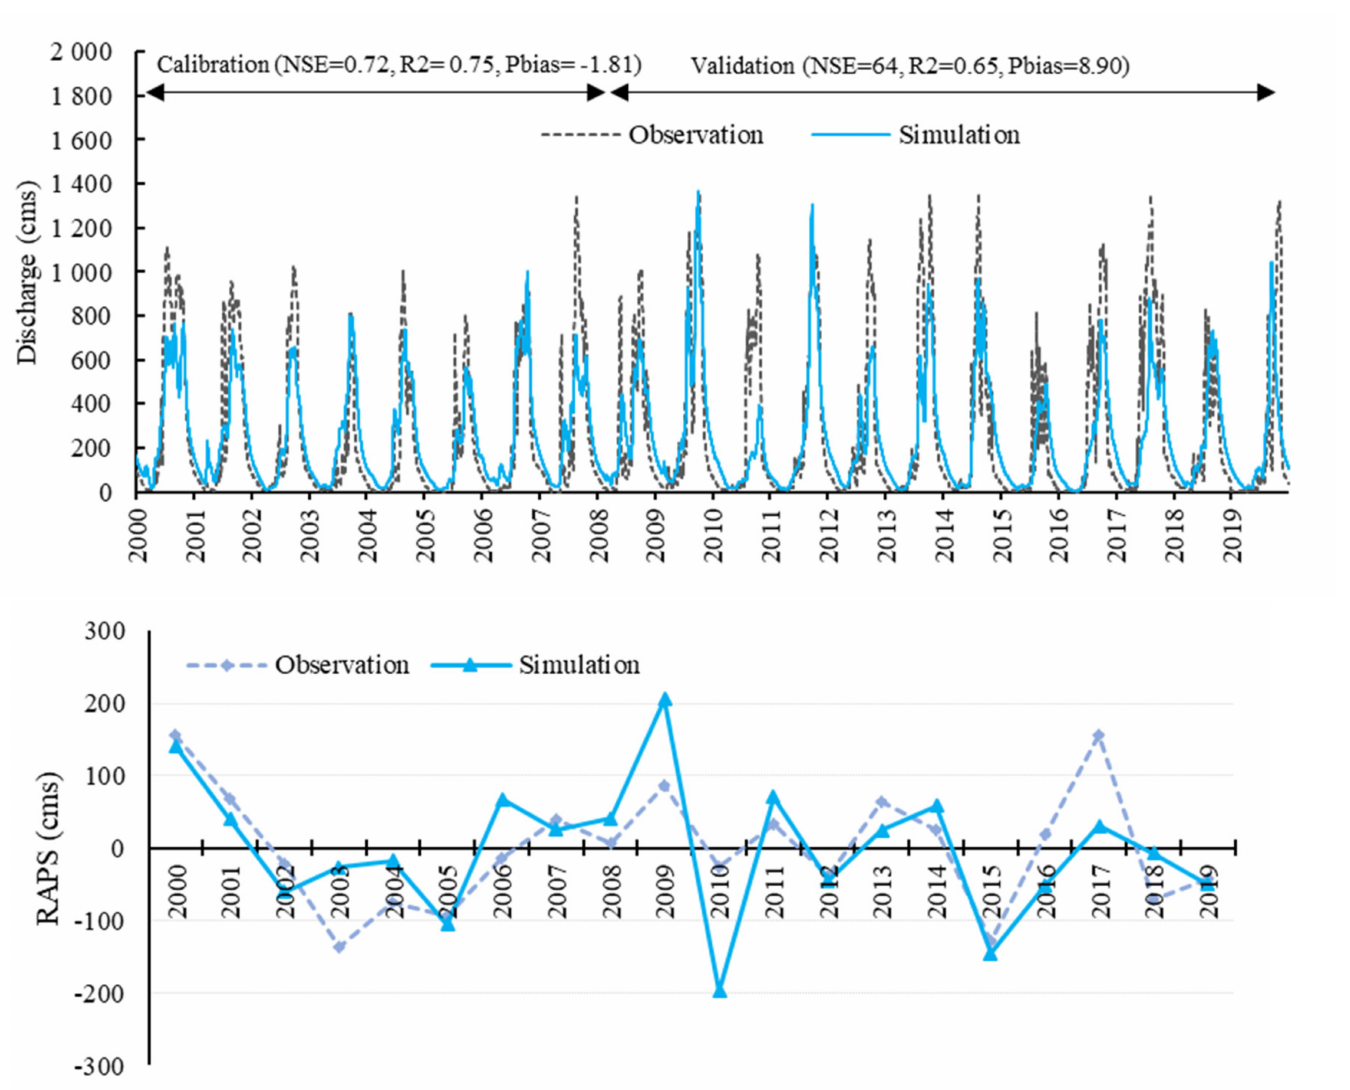
Figure 2. Time series of observed and simulated daily streamflow ( above ); and time series of RAPS of observation and simulation ( below